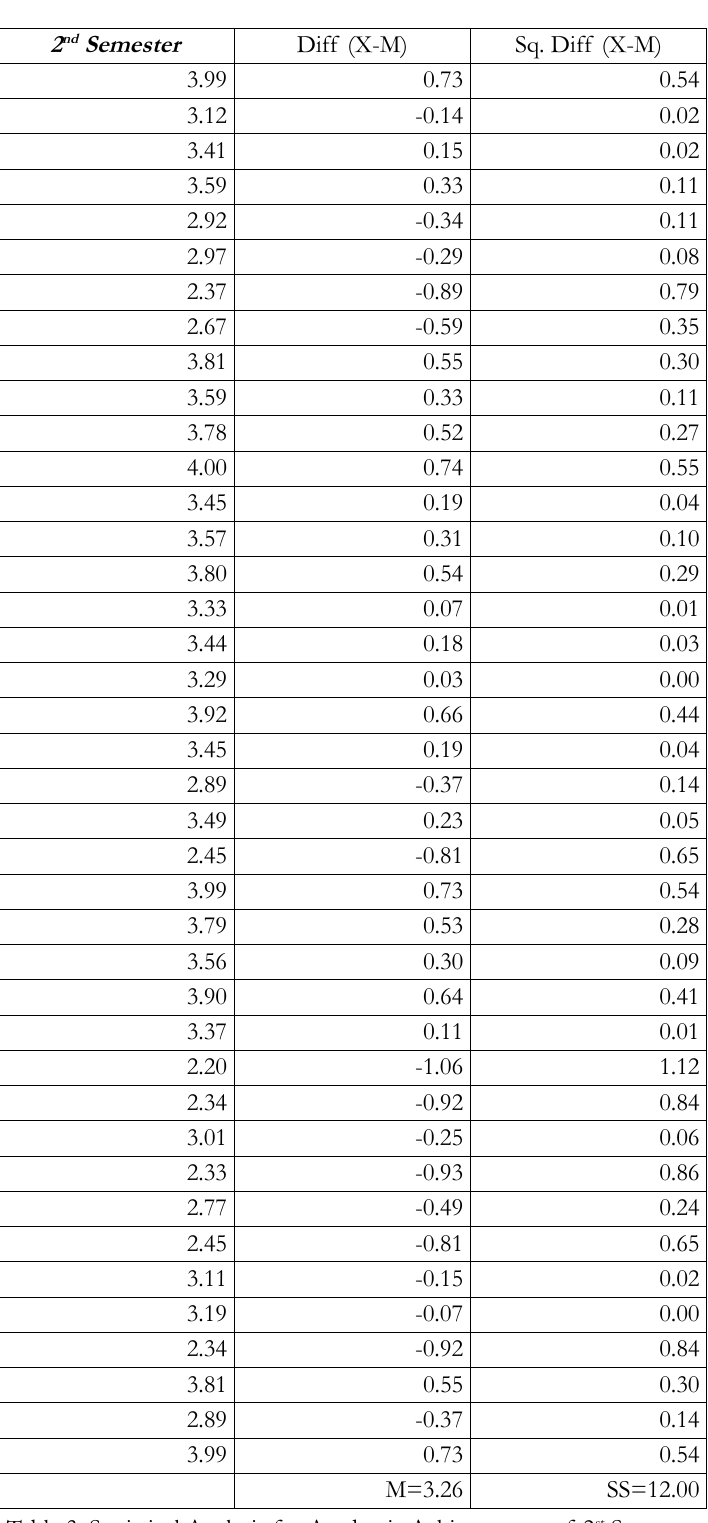
Table 3. Statistical Analysis for Academic Achievements of 2 st Semester